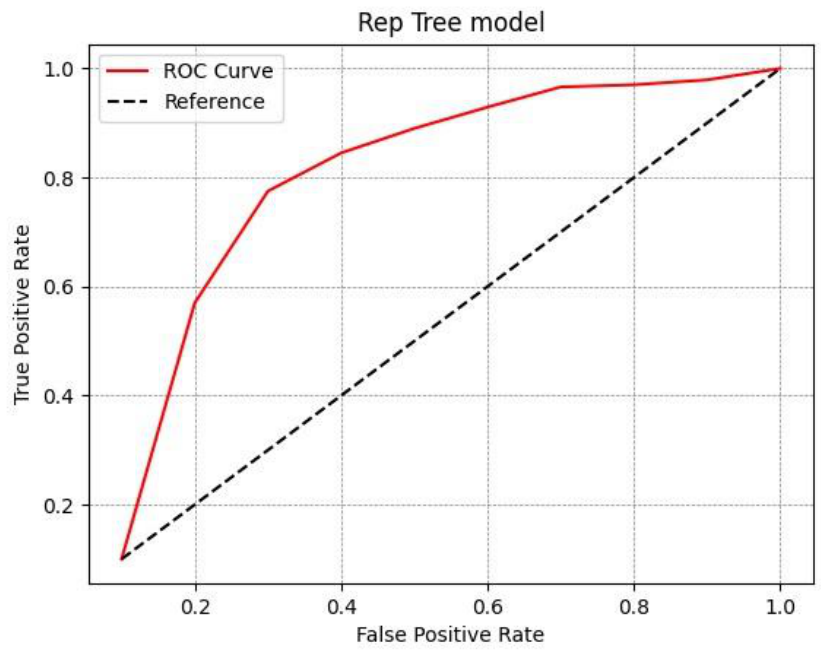
Figure 2. — ROC curve for the functional tree model.